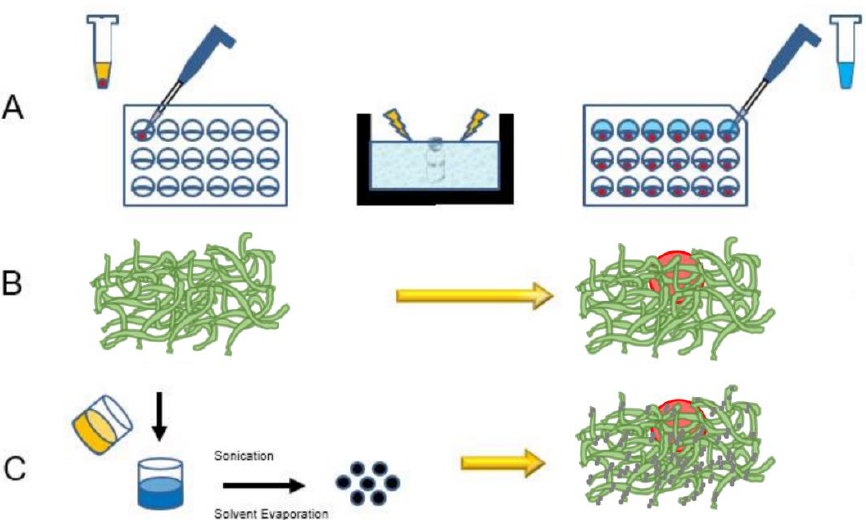
Figure 1. Schematic of experimental procedure. ( A ) Spheroids (shown in red) were embedded within PMX to better represent the tumor microenvironment and extracellular matrix (PMX solution shown in blue). ( B ) PMX self-assembles into a nanofiber architecture (green) around the tumor spheroid after exposure to media salts. ( C ) Spheroids embedded in PMX were treated with two NP formulations PEG and MPG (shown in yellow/navy), and the distribution was evaluated after 24 h incubation in normoxic and hypoxic conditions.